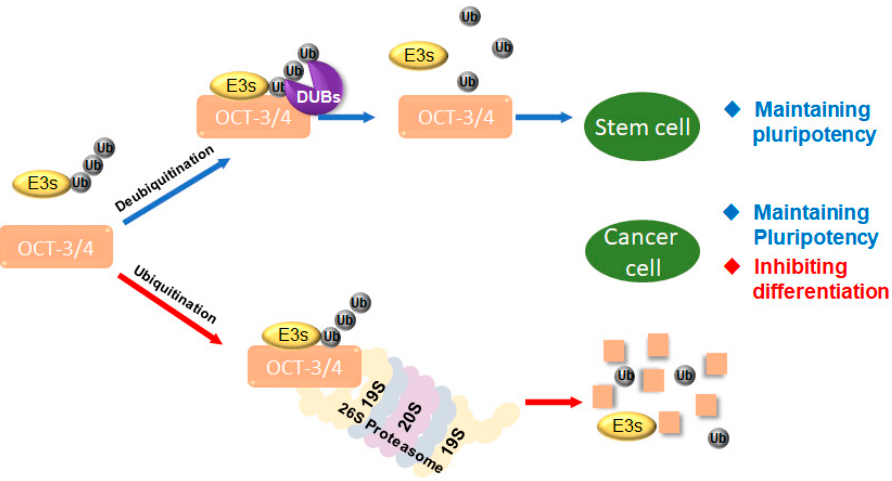
Figure 1. Interaction of target protein with ubiquitin ligases (E3s) and deubiquitinating enzymes (DUBs). E3s and DUBs regulate target proteins including transcription factors such as octamer-binding transcription factor 3/4 (OCT-3/4). DUBs regulate the stability of OCT-3/4. Proliferation and differentiation in cancer cells and stem cells are regulated by ubiquitination and deubiquitination systems.